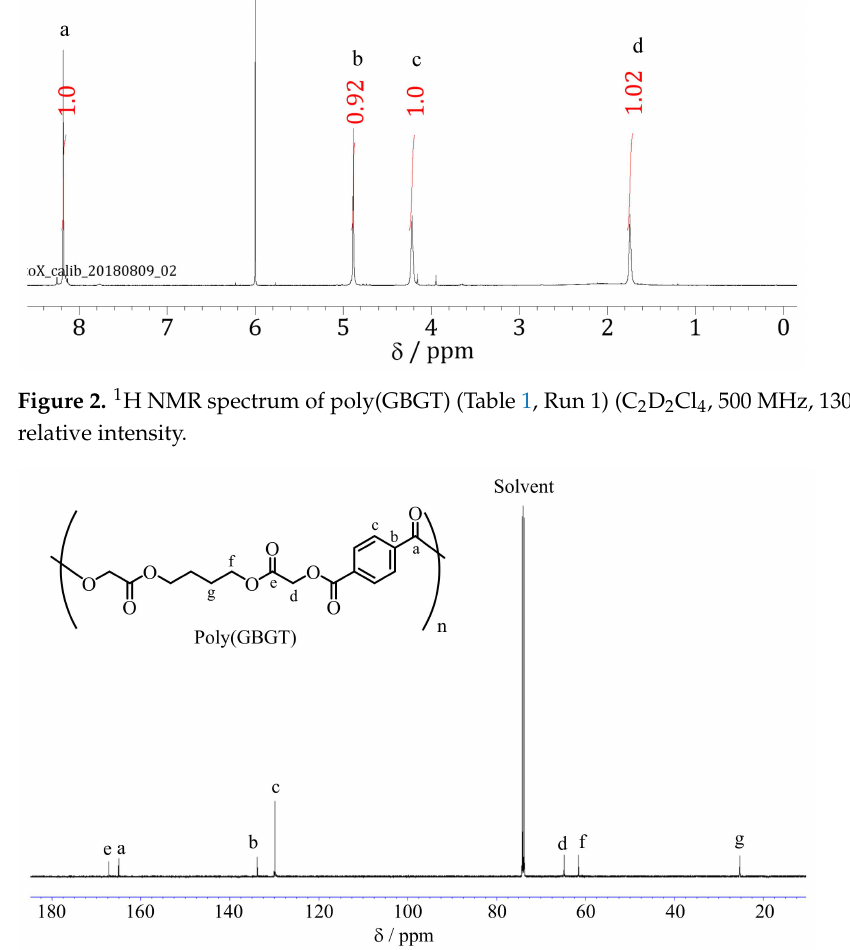
Figure 3. 13 C NMR spectrum of poly(GBGT) (Table 1, Run 1) (C 2 D 2 Cl 4 , 125 MHz, 130 ◦ C).